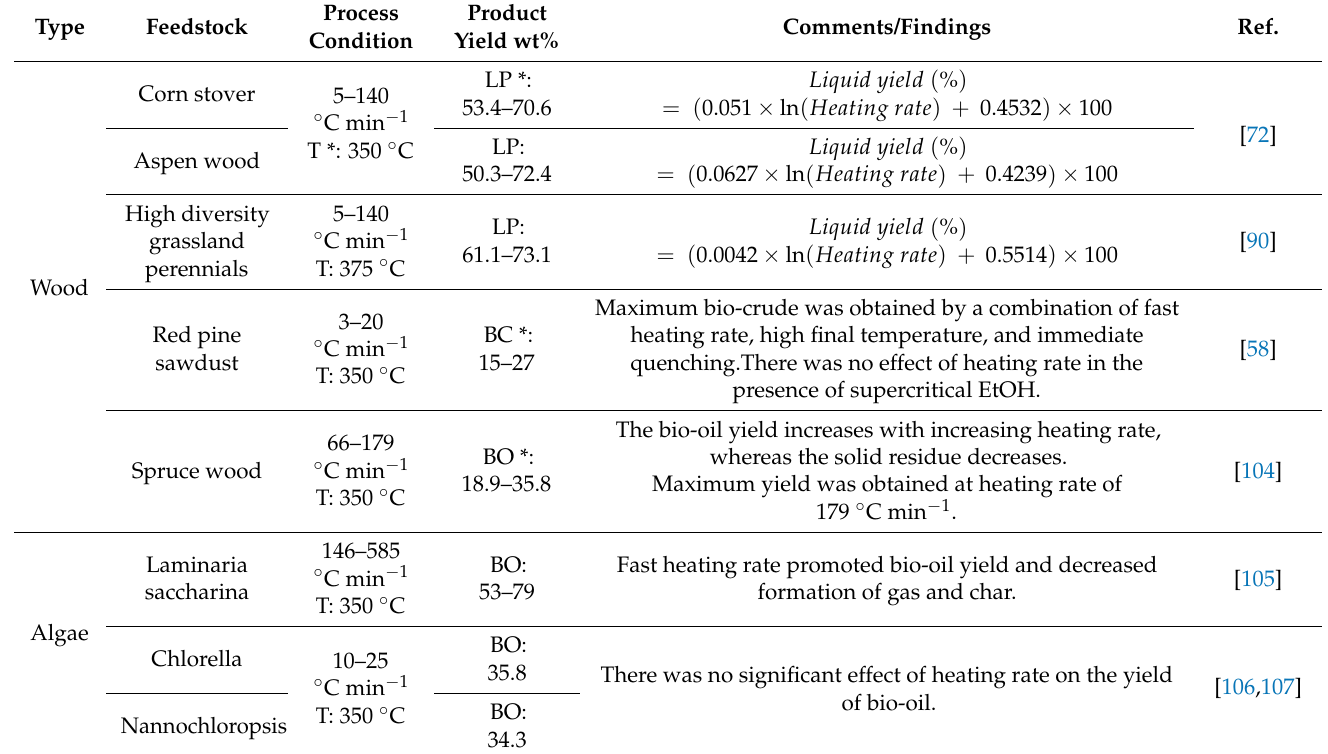
Table 6. Effect of heating rate in HTL